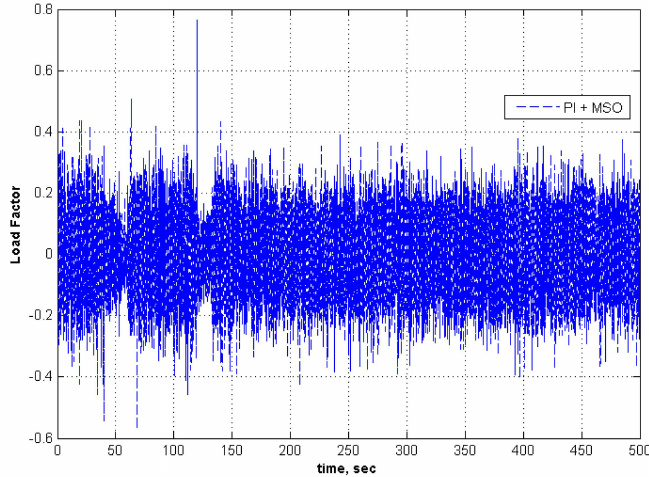
Figure 15. Load factor for 50% C m α in an aircraft.